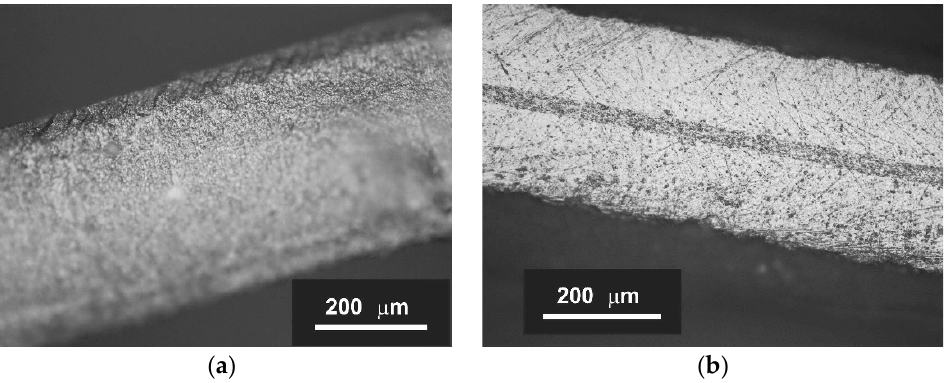
Figure 2. Image of a double-layer sample of LC/C_2/3//GDC-10 during heating at ( a ) 20 °C, ( b ) 915 °C, ( c ) 1120 °C and ( d ) 1200 °C. The LC/C_2/3 layer is at the bottom; the GDC-10 layer is at the top.